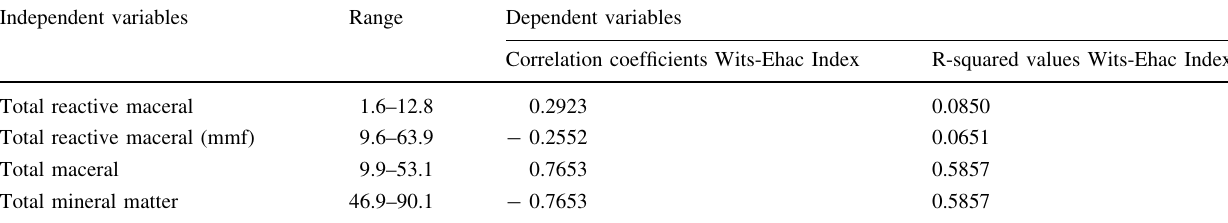
Table 7 Relationships between independent (total reactive maceral, total maceral analysis and total mineral matter-vol%) and dependent variables for the coal-shale samples